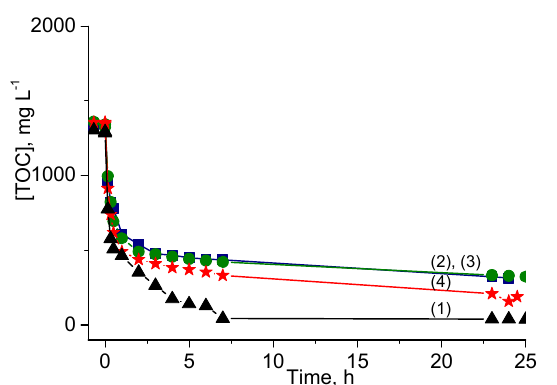
Figure 3. Evolution of TOC concentrations during the oxidation of diluted VBC at a temperature of 190 °C under 70 bar in the presence of 500 mg of 3wt% Ru/TiO 2 . First reaction ( ( 1 )), first recycling ( ■ ( 2 )), second recycling ( • ( 3 )), third recycling after re-activation under H 2 ( ( 4 )). Compared to the blank experiment (Figure 2), TOC conversion in the presence of Ru/TiO 2 or Ru/ZrO 2 was rapid from the beginning of the reaction and was as high as 50–60% after 20 min at 190 °C, compared to 60% after 7 h in the absence of catalyst. Reaction then slowed and TOC conversions rose to 97% and 99% after 24 h, respectively.